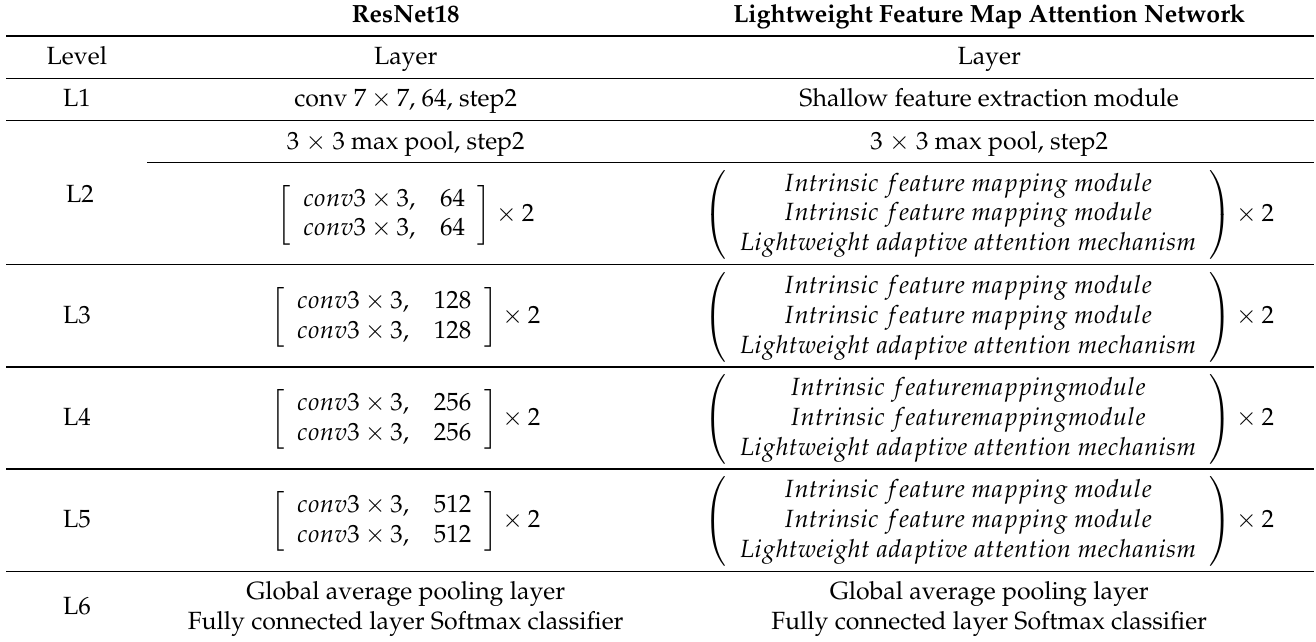
Table 2. Comparison of ResNet18 and lightweight feature mapping attention network structure.